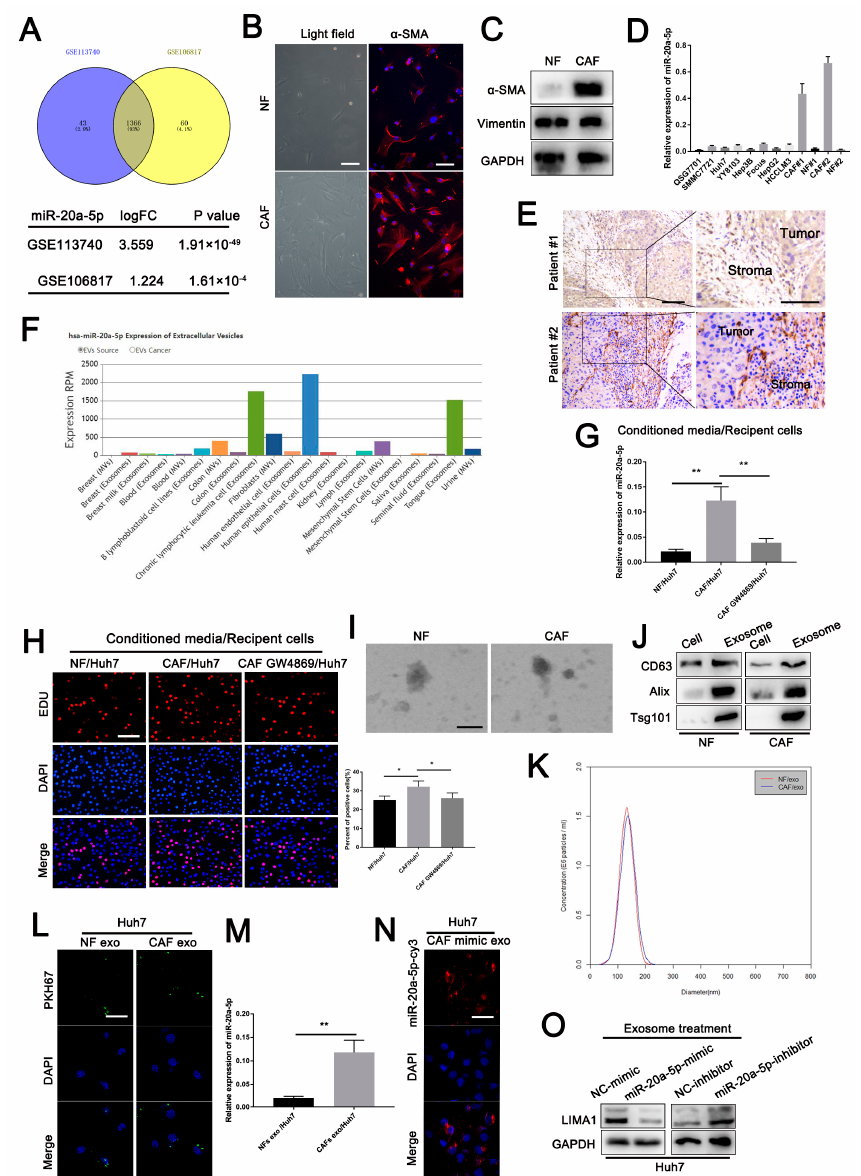
Figure 6. CAF-derived exosomes carrying miR-20a-5p-mediated HCC cell progression. ( A ) MiR-20a-5p was detected in HCC patients’ peripheral blood based on data sets GSE113740 and GSE106817. ( B ) CAFs and NFs obtained from two HCC patients were verified based on morphology and immunofluorescence for vimentin. ( C ) Western blotting for α -SMA and vimentin in CAFs and NFs was performed. ( D ) RT-qPCR was employed to examine the miR-20a-5p expression in normal liver cells, HCC cell lines, CAFs and NFs. ( E ) The location of miR-20a-5p in HCC tissues was deter- mined based on in situ hybridisation (ISH). ( F ) The expression of miR-20a-5p in exosomes secreted from fibroblasts was predicted by using the EVmiRNA database. ( G ) Huh7 cells were cultured in